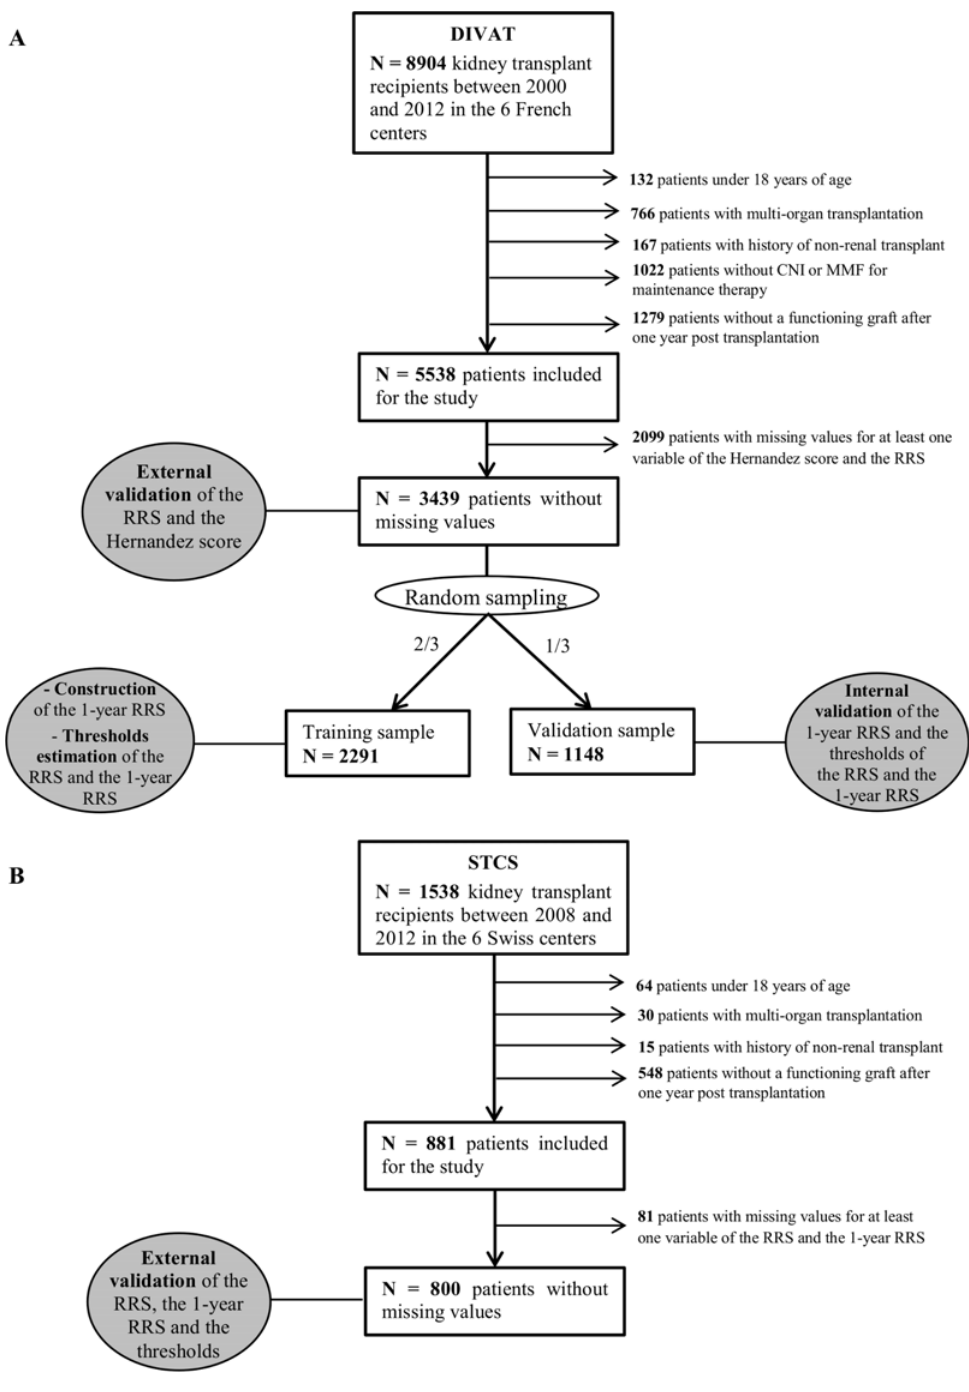
Fig 1. Flowcharts presenting the steps of the patient inclusion in (A) the French DIVAT cohort and (B) the Swiss STCS